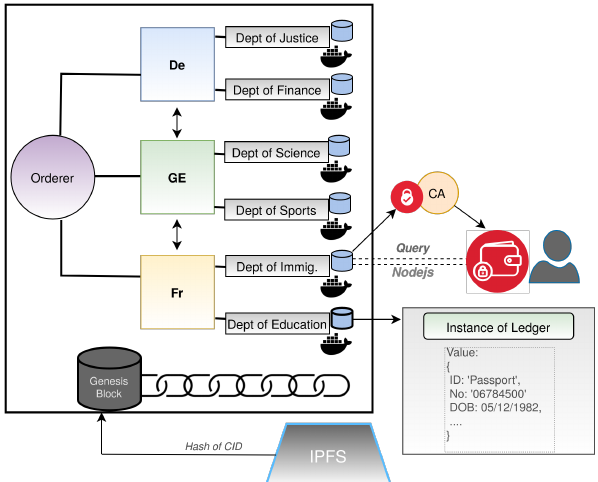
Figure 1. An overview of a distributed data-sharing platform based on permissioned